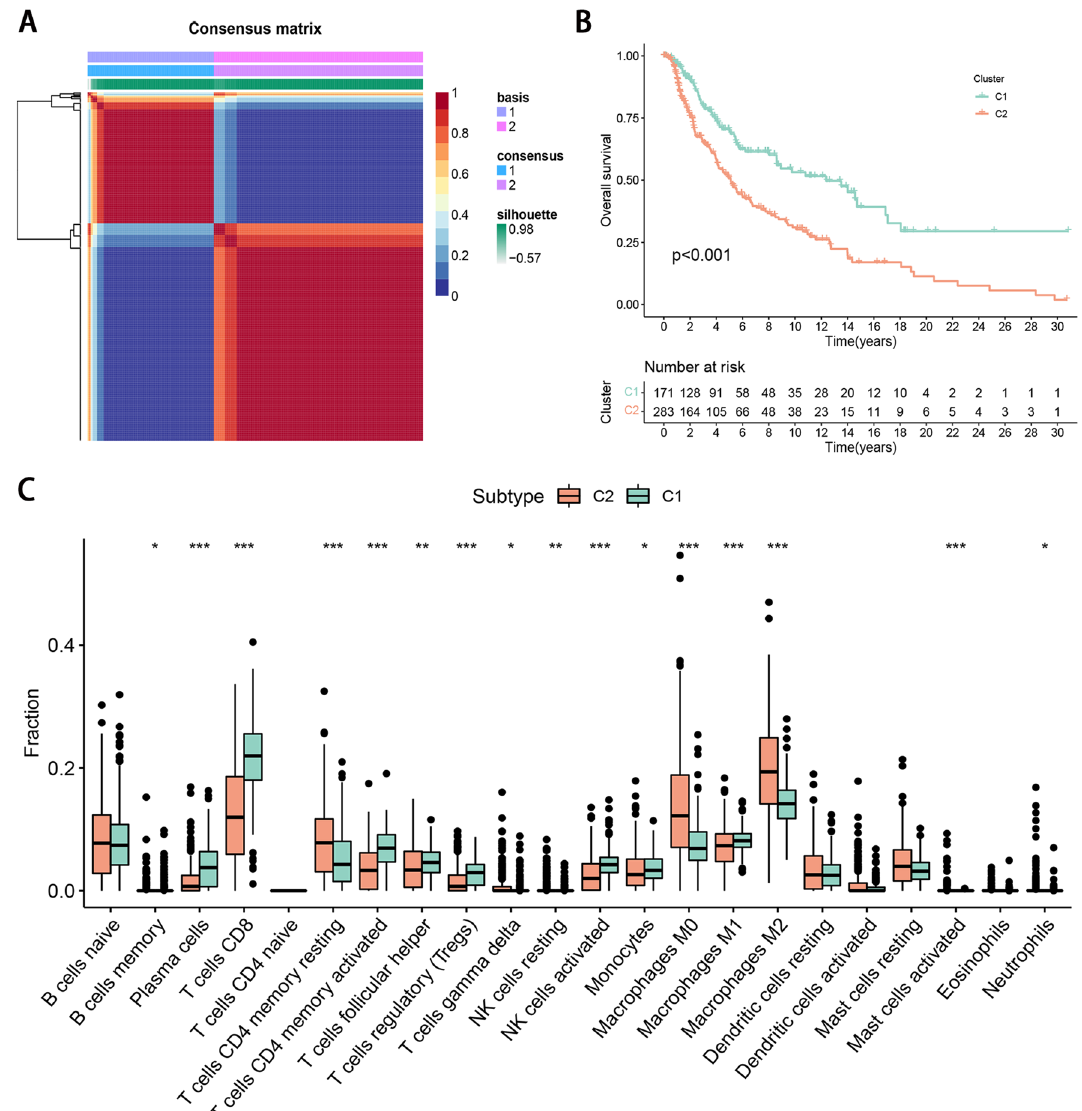
immune infiltration cells between the two